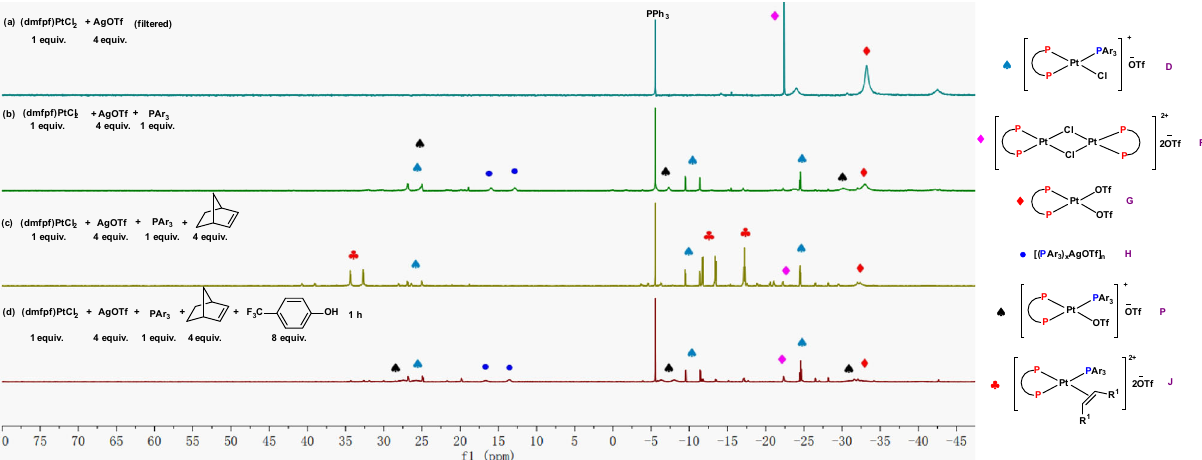
Fig. 9 31 P NMR spectra for the reaction of dmfpfPtCl 2 + AgOTf (4 equiv.) + PAr 3 + norbornene + 4-tri fl uromethylphenol (PPh 3 was used as an external standard). a 31 P NMR spectra of a mixture of (dmfpf)PtCl 2 (1 equiv.) and AgOTf (4 equiv.) after fi ltration. b 31 P NMR spectra of a mixture of (dmfpf)PtCl 2 (1 equiv.), AgOTf (4 equiv), and tris(3,4,5-tri fl uorophenyl)phosphane (1 equiv.) after fi ltered. c 31 P NMR spectra of a mixture of (dmfpf)PtCl 2 (1 equiv.), AgOTf (4 equiv.), tris(3,4,5-tri fl uorophenyl)phosphane (1 equiv.), and norbornene (4 equiv.) after fi ltered. d 31 P NMR spectra of a mixture of (dmfpf)PtCl 2 (1 equiv.), AgOTf (4 equiv.), tris(3,4,5-tri fl uorophenyl)phosphane (1 equiv.), norbornene (4 equiv.), and 4-tri fl uoromethylphenol (8 equiv.).